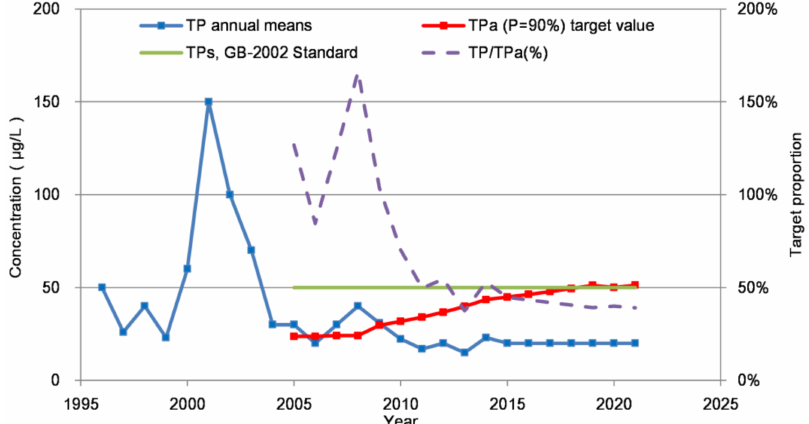
Figure 7. Dynamic process analysis of the total phosphorus-carrying concentration, TPa, in the Chaihe